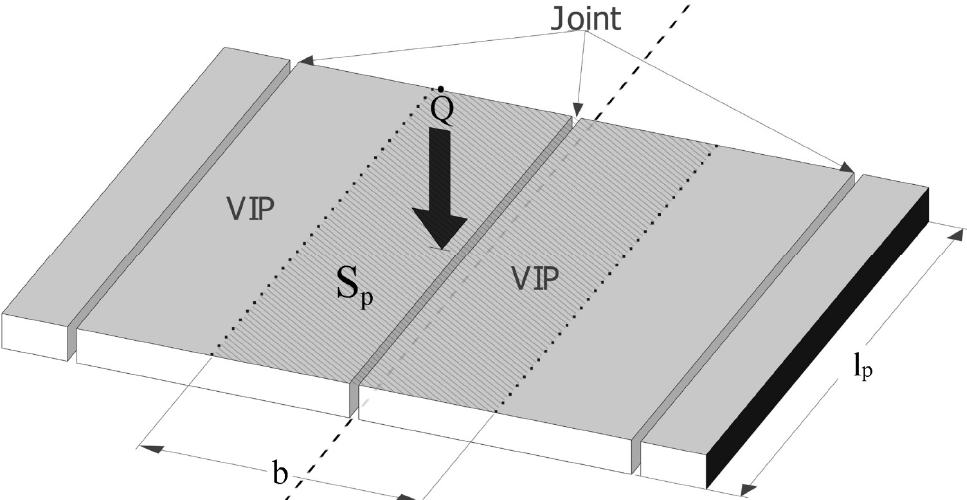
Figure 6. 3D scheme of the numerical calculation of the effective VIP thermal